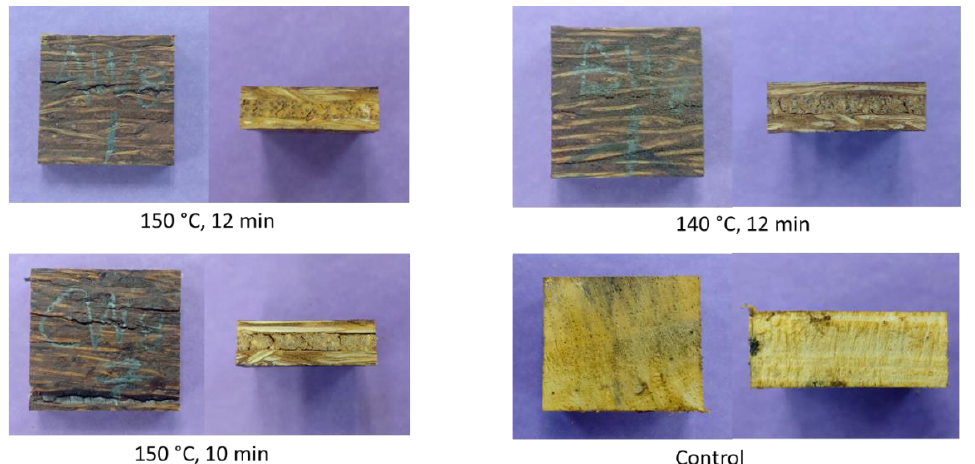
Figure 6. Visual appearance of the MGE plywood and control samples after an 8-week exposure to white rot fungi.